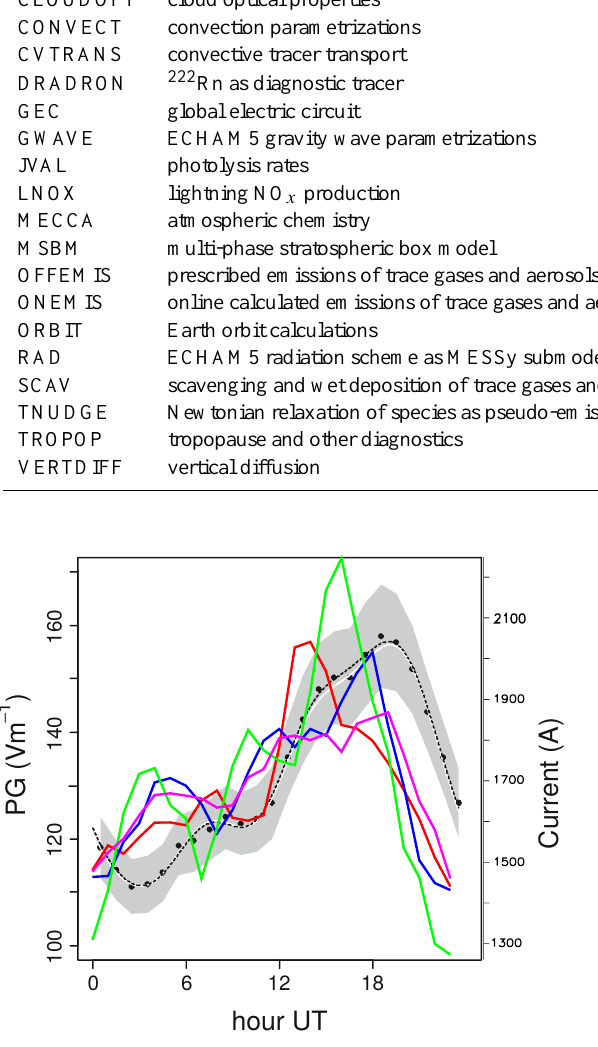
Figure 2. Black/grey: re-calculated Carnegie curve, showing the potential gradient (PG), taken from Harrison (2013). Coloured lines: composite day parametrized GEC source current averaged over 45 ◦ S to 45 ◦ N from additional CESM1/MESSy and EMAC sensitivity simulations. Red: CMAC-FV with Tiedtke/Nordeng convection scheme; blue: CMAC-FV with Bechtold convection scheme; purple: CMAC-SE with Bechtold convection scheme; green: EMAC with Tiedtke/Nordeng convection